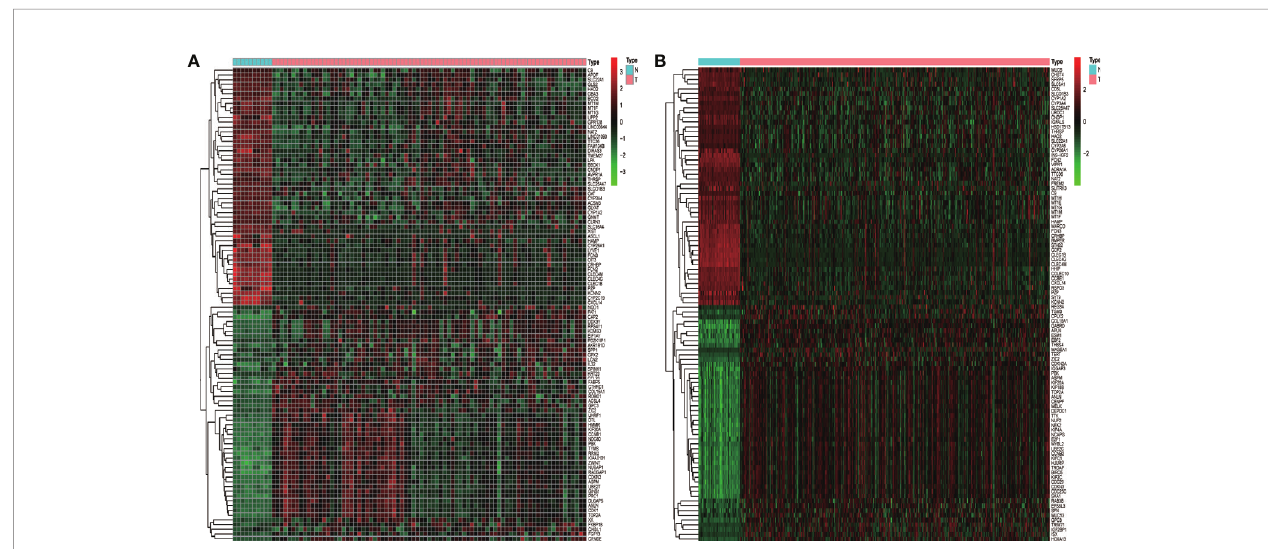
FIGURE 3 | The heatmaps of DEGs between HCC and normal tissues. (A) Heatmap of the GSE62232 dataset. (B) Heatmap of the TCGA dataset. Red represents the upregulated genes and green represents the downregulated